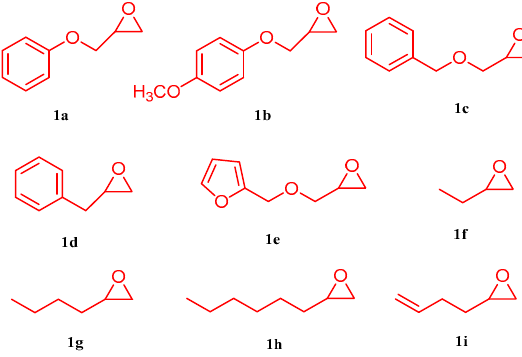
Figure 4. Selected epoxides for the reaction with KSA.